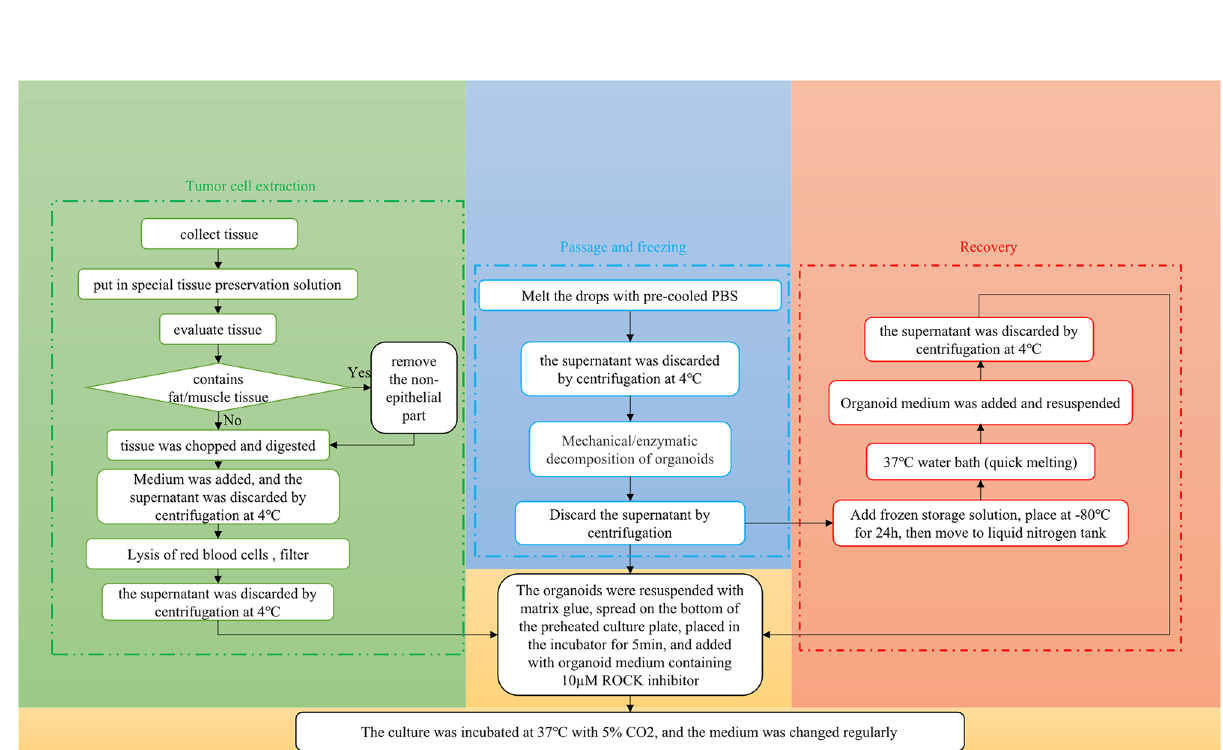
Figure 2. Culture process of tumor organoids. From left to right, tumor cell extraction, as well as organoid passage, cryopreservation and